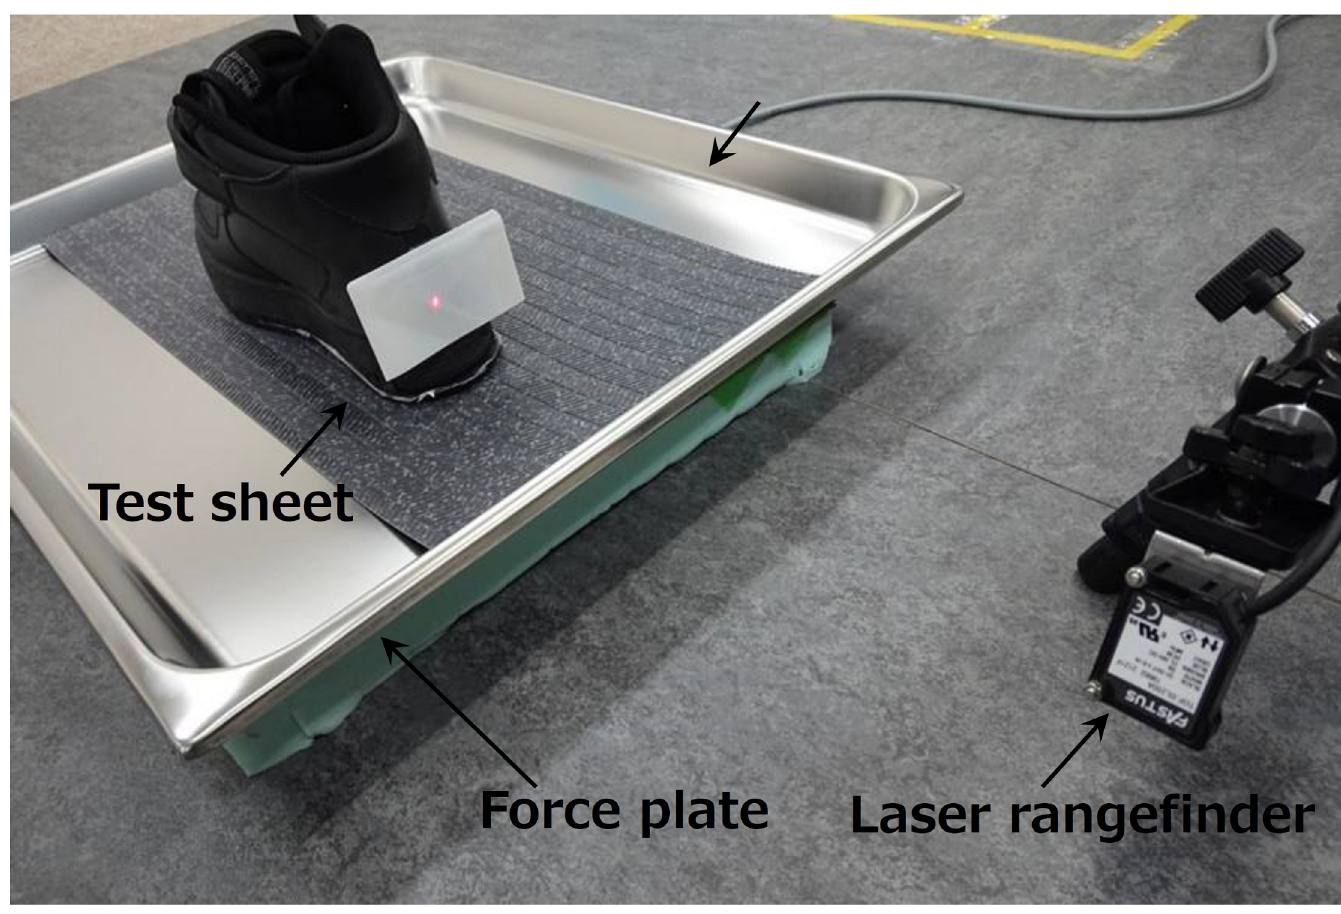
Fig 3. Photo of experimental